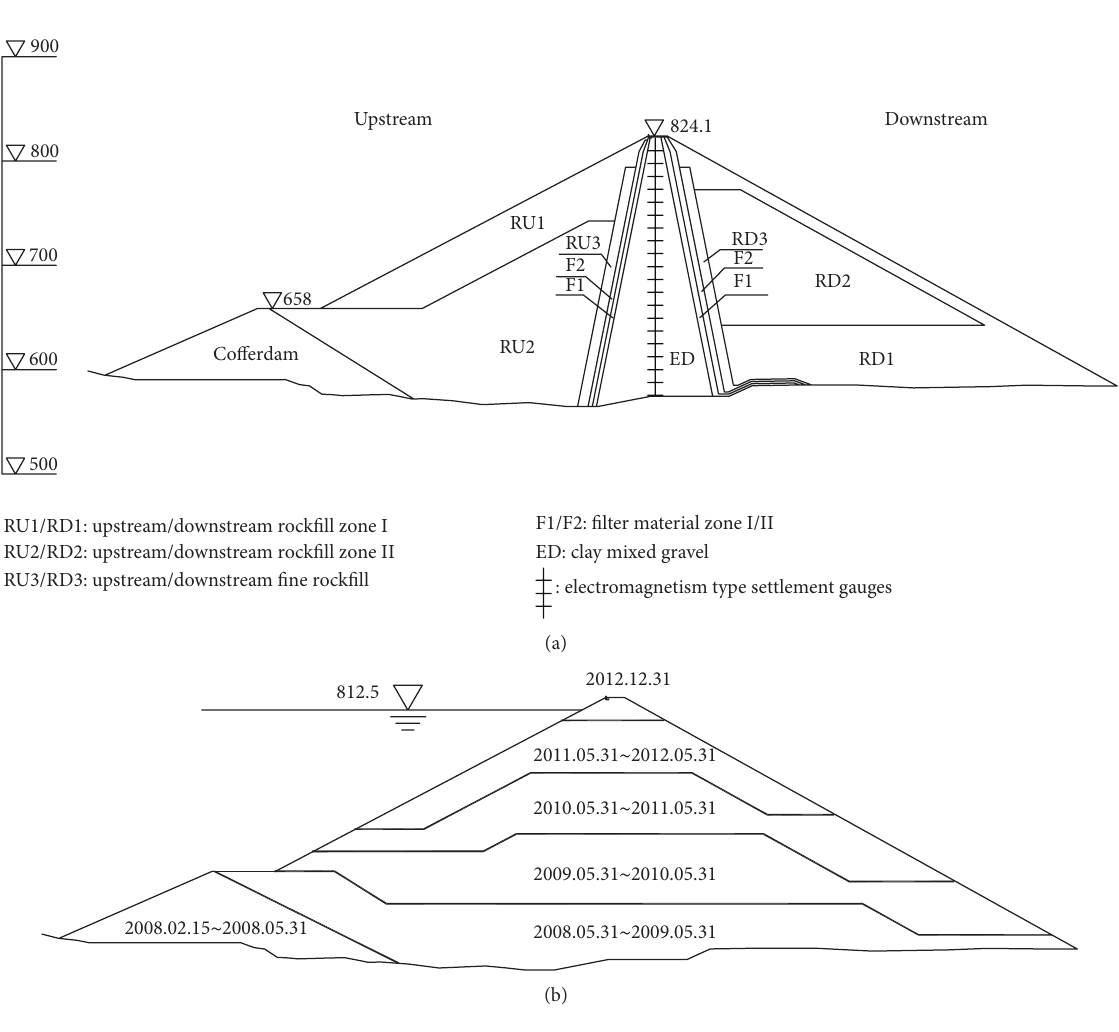
Figure 3: The maximum cross-section. (a) Material zoning and (b) construction stage.